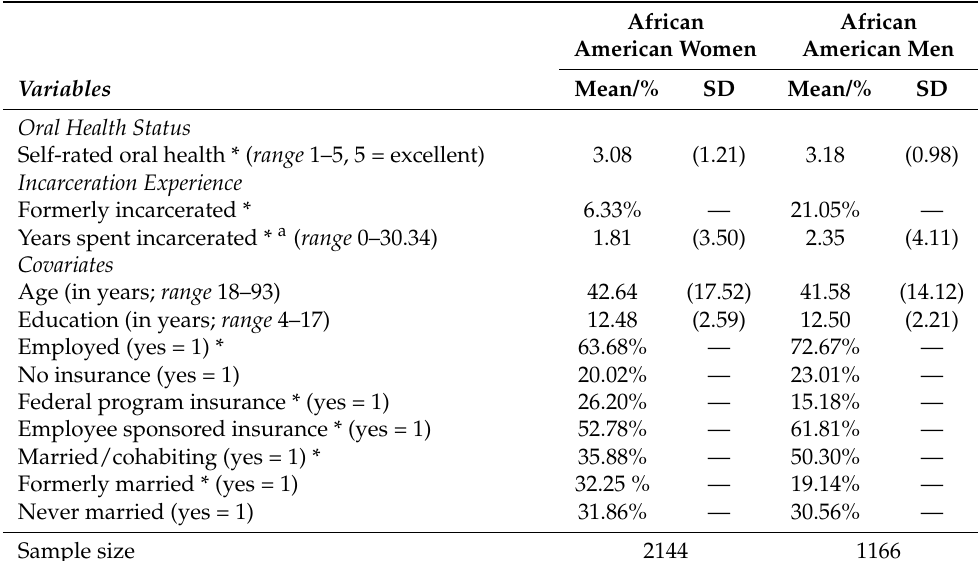
Table 1. Descriptive statistics for African American women and men in the National Survey of American Life, 2003.